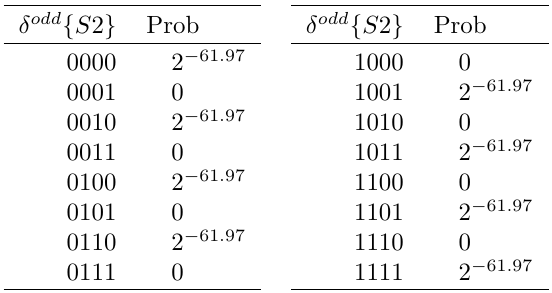
Table 20: Conditioning the Probability of the 16-Round Iterative Characteristic on Each of the 16 Possible Values of δ odd { S 2 }